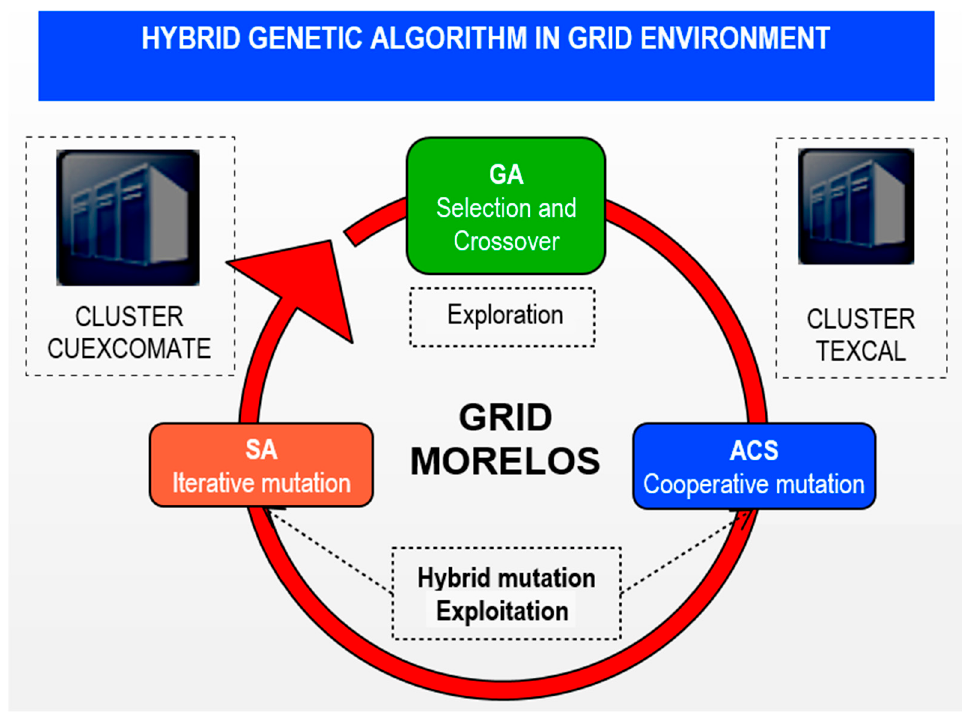
Figure 4. The HGAG in a grid environment using two clusters.